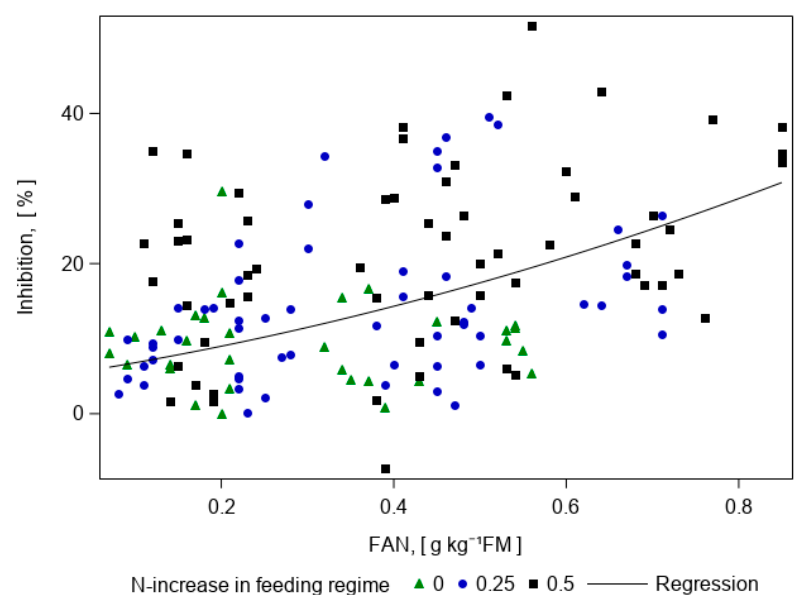
Figure 5. The correlation between the free ammonia nitrogen (FAN) and the inhibition in specific methane yield (Inhibition). The “0”, “0.25” and “0.5” marks in the legend correspond to the N-increase variants of “0-increase”, “0.25-increase” and “0.5-increase” in the feeding regimes. The regression line was built based on the results obtained from the model.